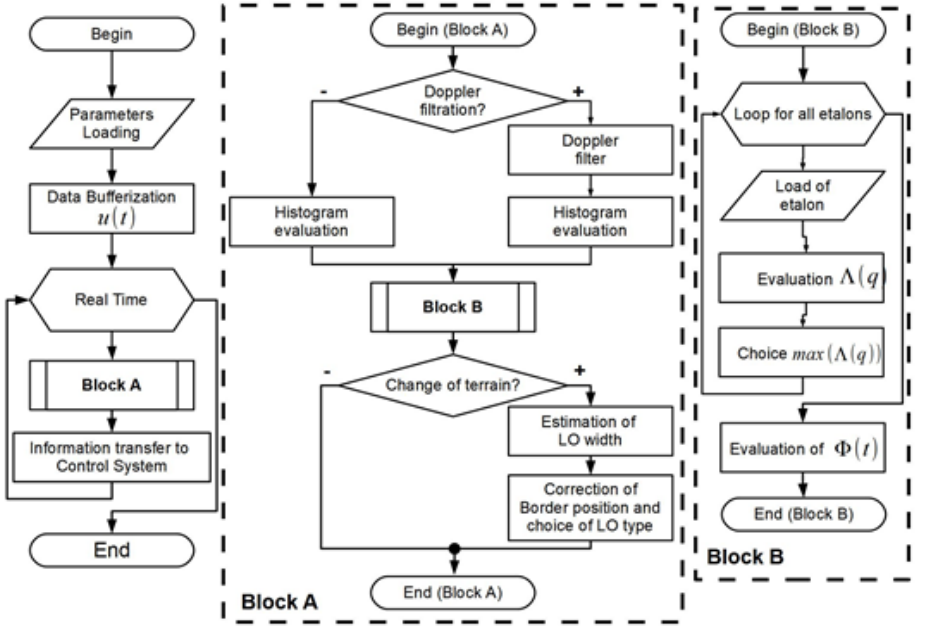
Fig. 2. Structural scheme of lengthened objects detection algorithm